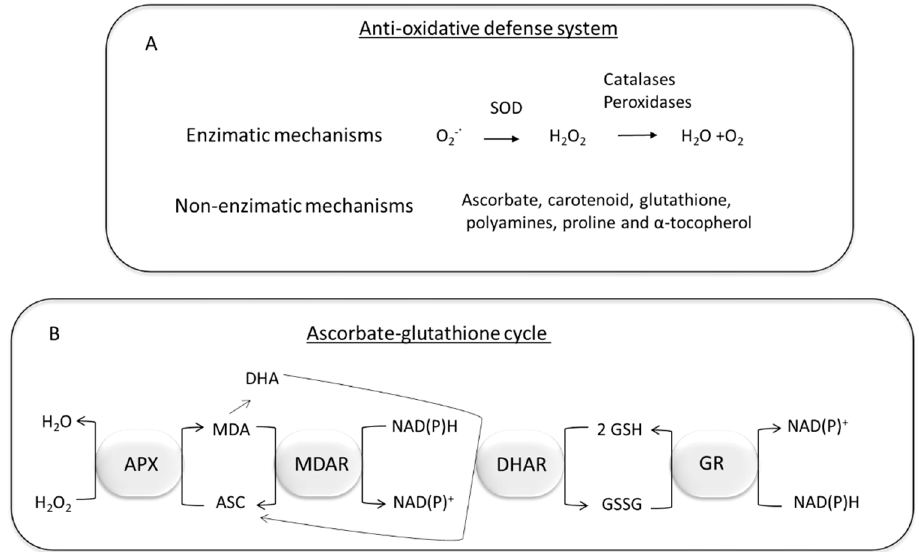
Figure 5. Schematic representation of the anti-oxidative defence system in plants ( A ) and the ascorbate-glutathione cycle. ( B ) SOD: Superoxide dismutase; APX: ascorbate peroxidase; ASC: ascorbate; GSH glutathione; MDA: monodehydroascorbate; MDAR: monodehydroascorbate reductase; DHA: dehydroascorbate; DHAR: dehydroascorbate reductase; GSSG: oxidized glutathione; GR glutathione reductase (modified from [183]).